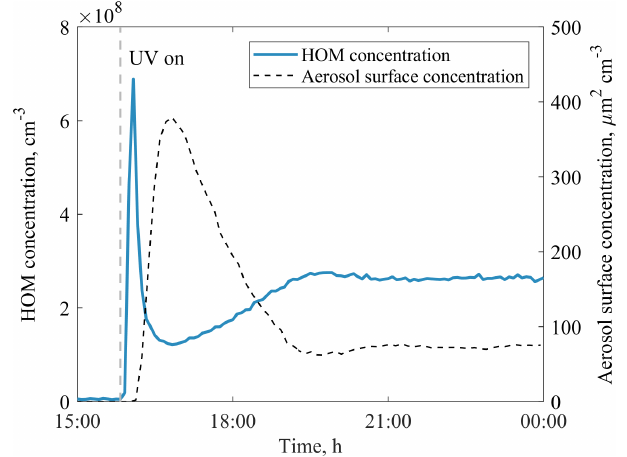
Figure 2. An example of JPAC reaching steady state after the UV lamp was switched on in experiment no. 20. Within a few minutes, the concentration of HOMs increased significantly, triggering par- ticle formation in the chamber, which acted as a sink for HOMs. After both the gas- and particle-phase signals reached steady state (in ∼ 5h) the HOM yield was